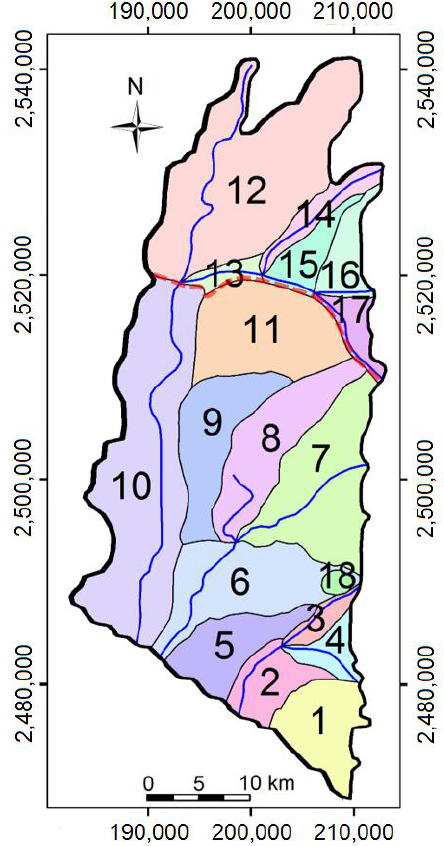
Figure 5. Hydrologic response units (HRUs) defined for the proposed simulation domains (note that HRU 18 is the artificial recharge lake).